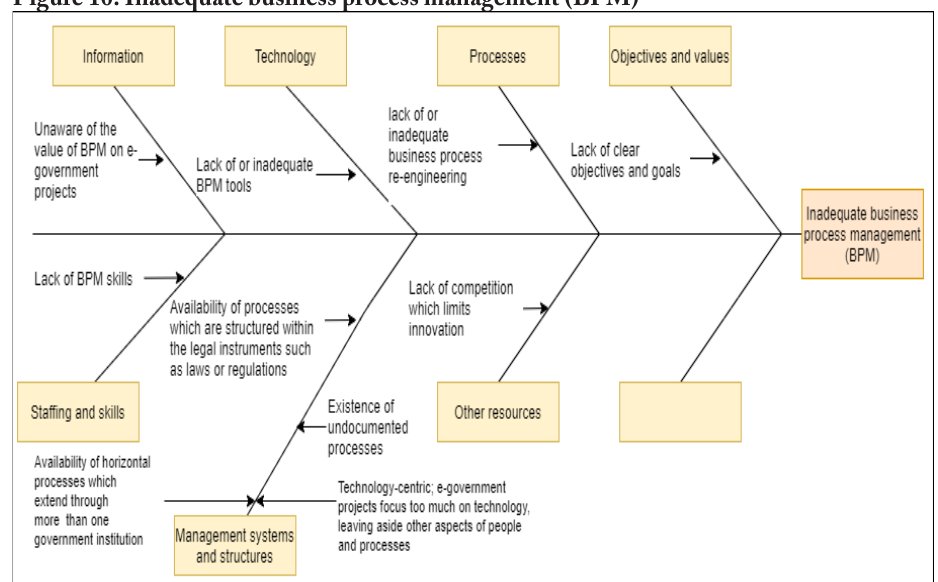
Insuff icient IS